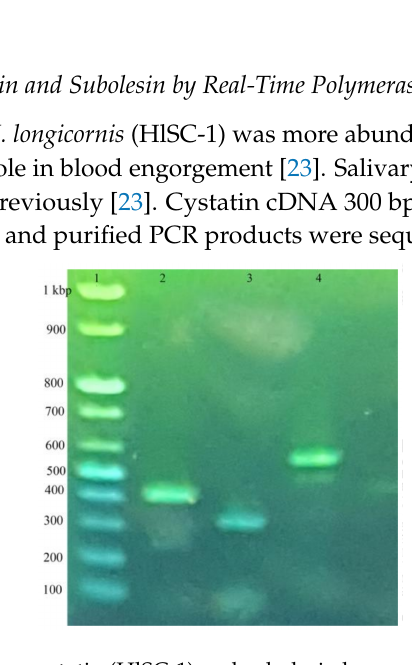
Figure 1. Detection of salivary cystatin (HlSC-1) and subolesin by semi-quantitative RT-PCR. Salivary glands were collected from adult female H. longicornis which had been fed for five days. Total RNA was extracted, and a cDNA synthesis was performed. An RT-PCR was performed using gene-specific primers. Lane 1 indicates a 100 bp DNA ladder; lane 2, subolesin 396 bp; lane 3, cystatin 300 bp; and lane 4, actin 540